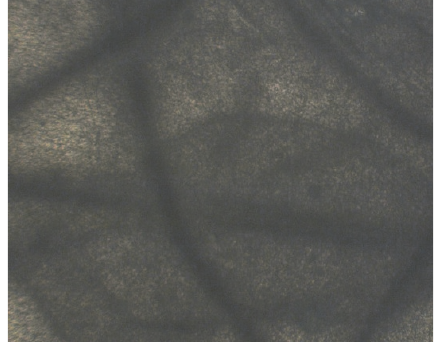
Figure 5: Fluorescence microscope image of PA6.